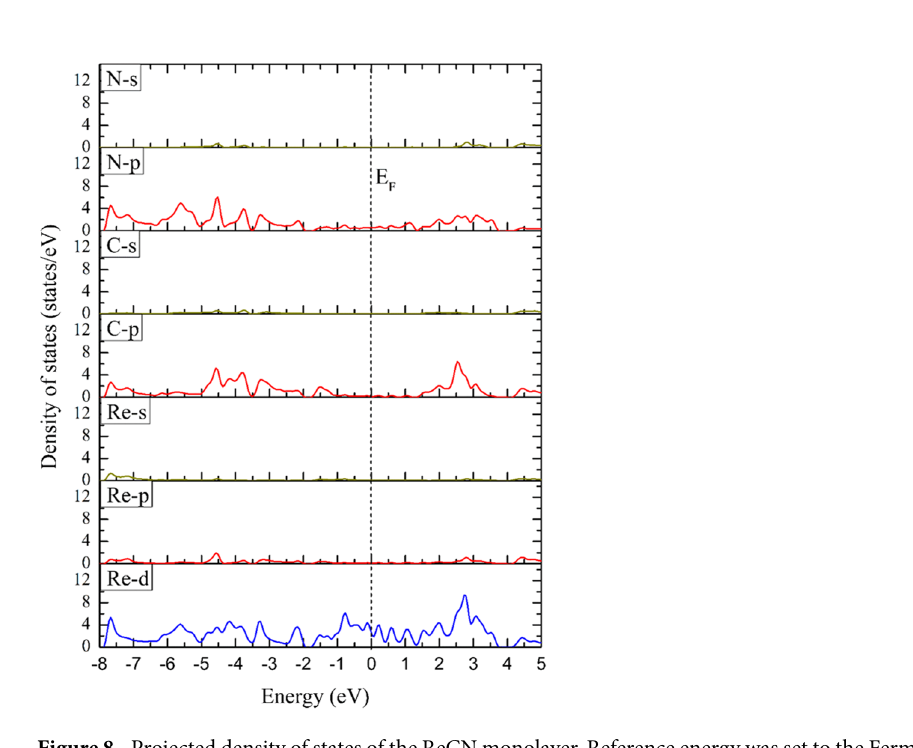
Figure 8. Projected density of states of the ReCN monolayer. Reference energy was set to the Fermi